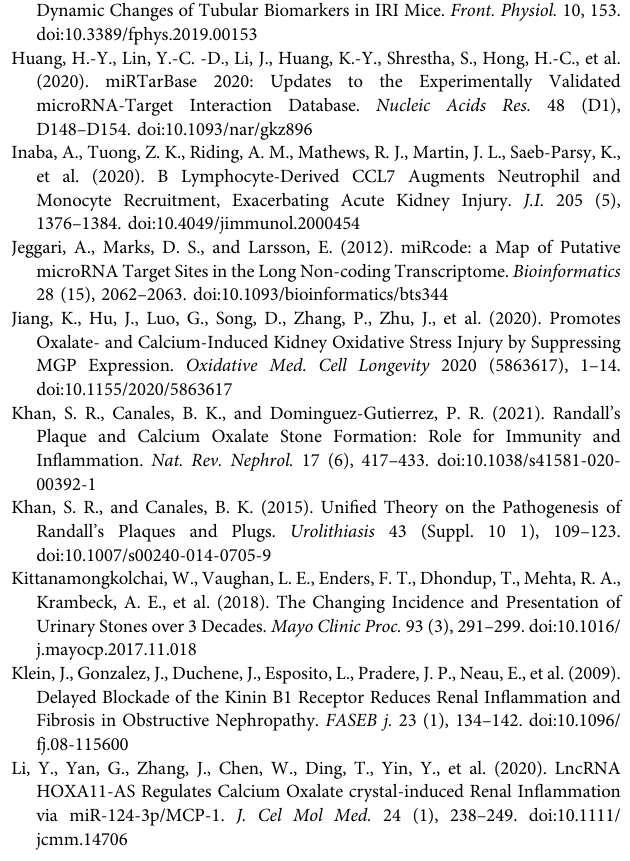
Supplementary Figure 1 | PPI network of lncRNA-related differentially expressed mRNAs. Supplementary Table S1 | Sequence of primers used for